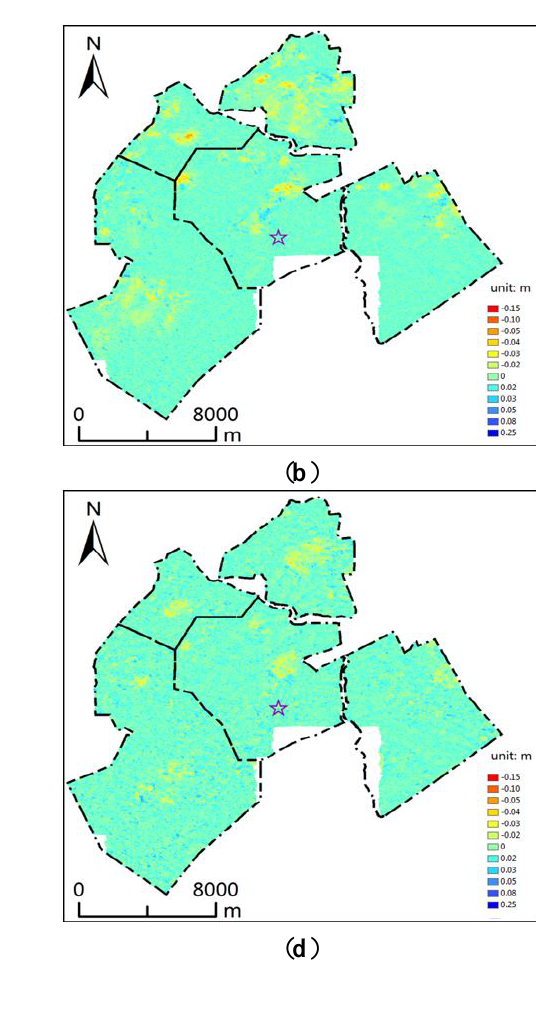
Figure 4. Displacement maps with clear deformation signals generated from ENVISAT and ALOS